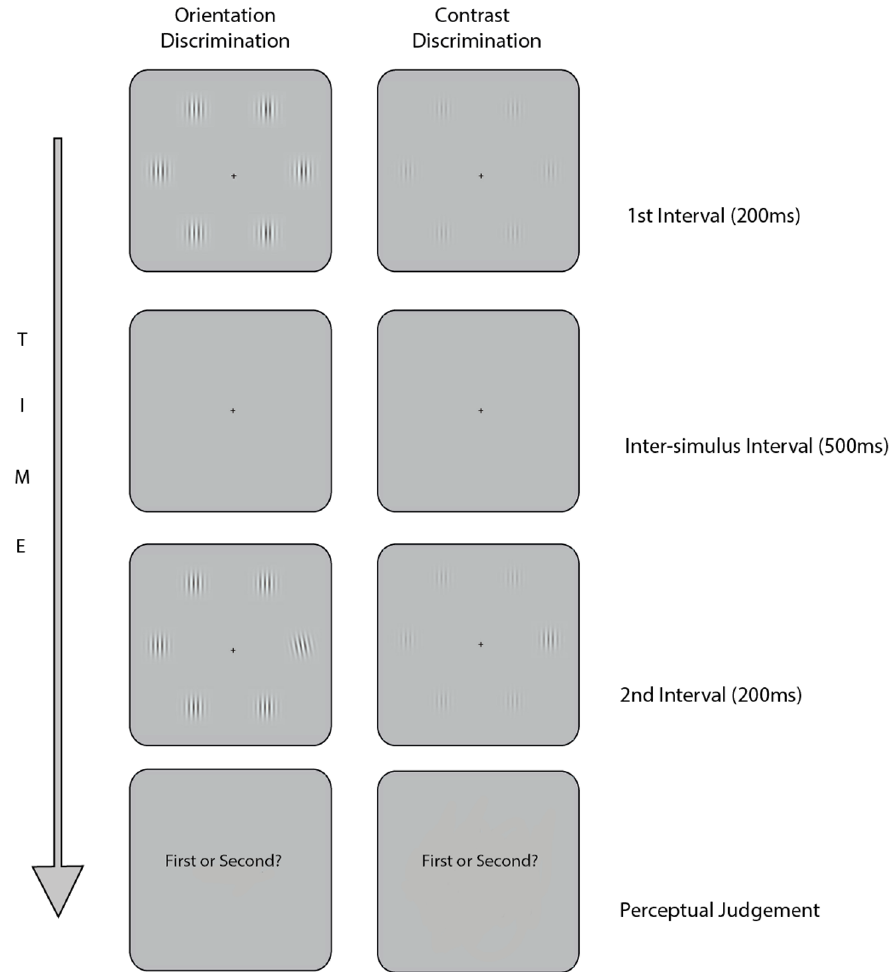
Figure 1. A schematic diagram of the experimental paradigm. Left: Contrast Discrimination task, Right: Orientation Discrimination task. Participants made a two-interval forced choice judgment on which temporal interval (i.e. first or second) contained the grating that popped out in contrast (left panel) or orientation (right panel).